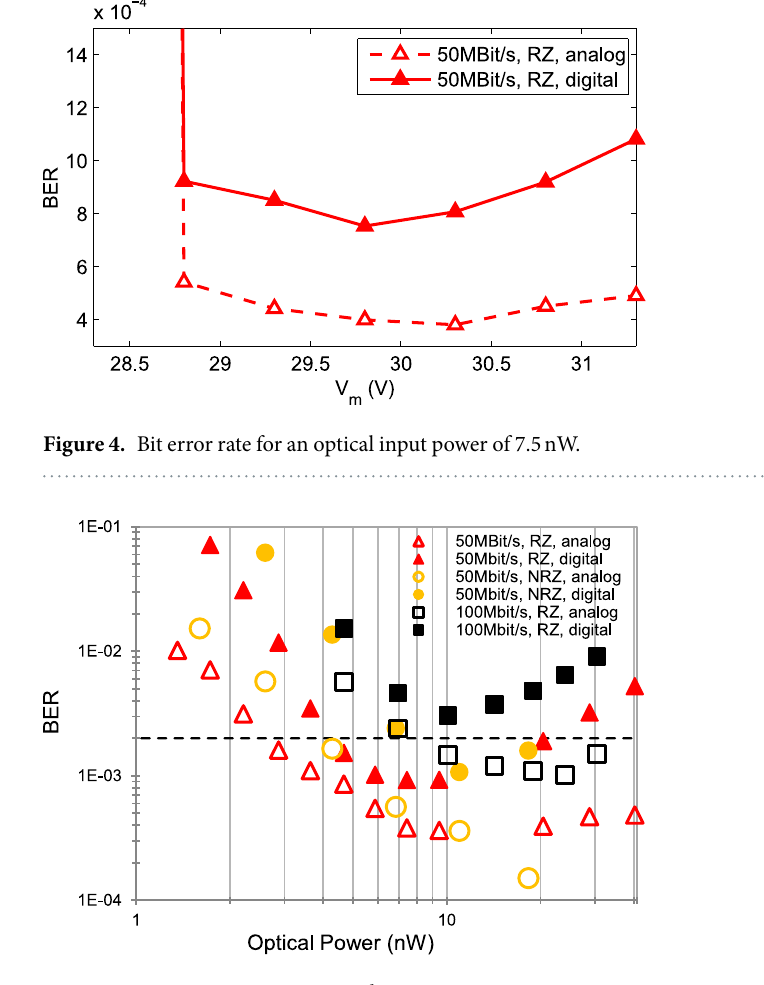
Figure 5. BER versus average optical input